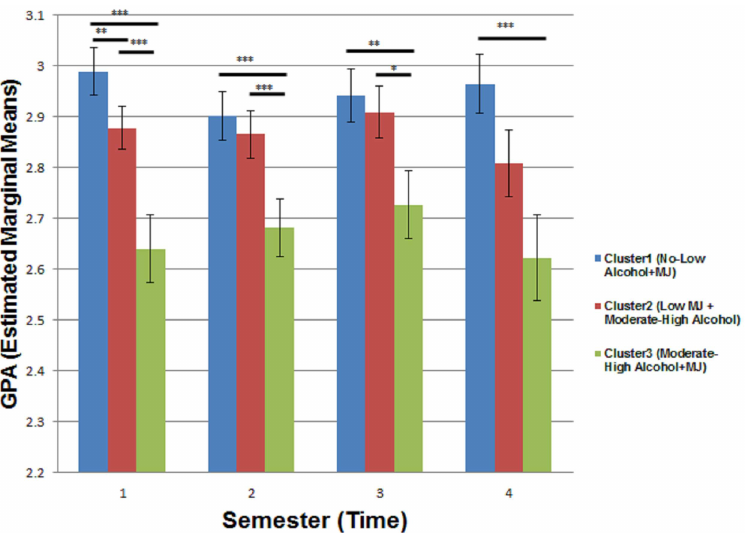
Fig 2. Linear mixed model plot. Bar plot of GPA (estimated marginalmeans) across semesters by cluster. Post-hoc between-group analysis(using a sidak correction for multiplecomparisons) is also indicated. Between-cluster, post-hoc significances are marked as follows: *** p < 0.001, ** p < 0.005, * p < 0.01.Note: Error bars represent standard error of mean.